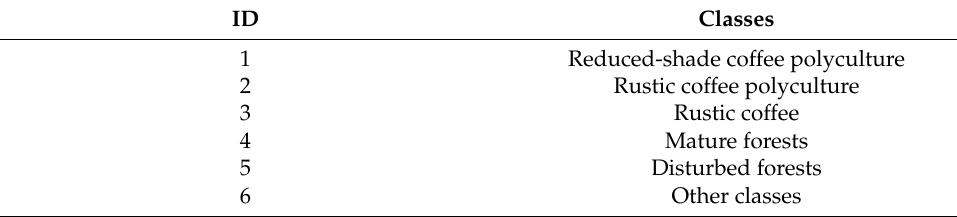
Table 1. AFS and land-cover classes in the study